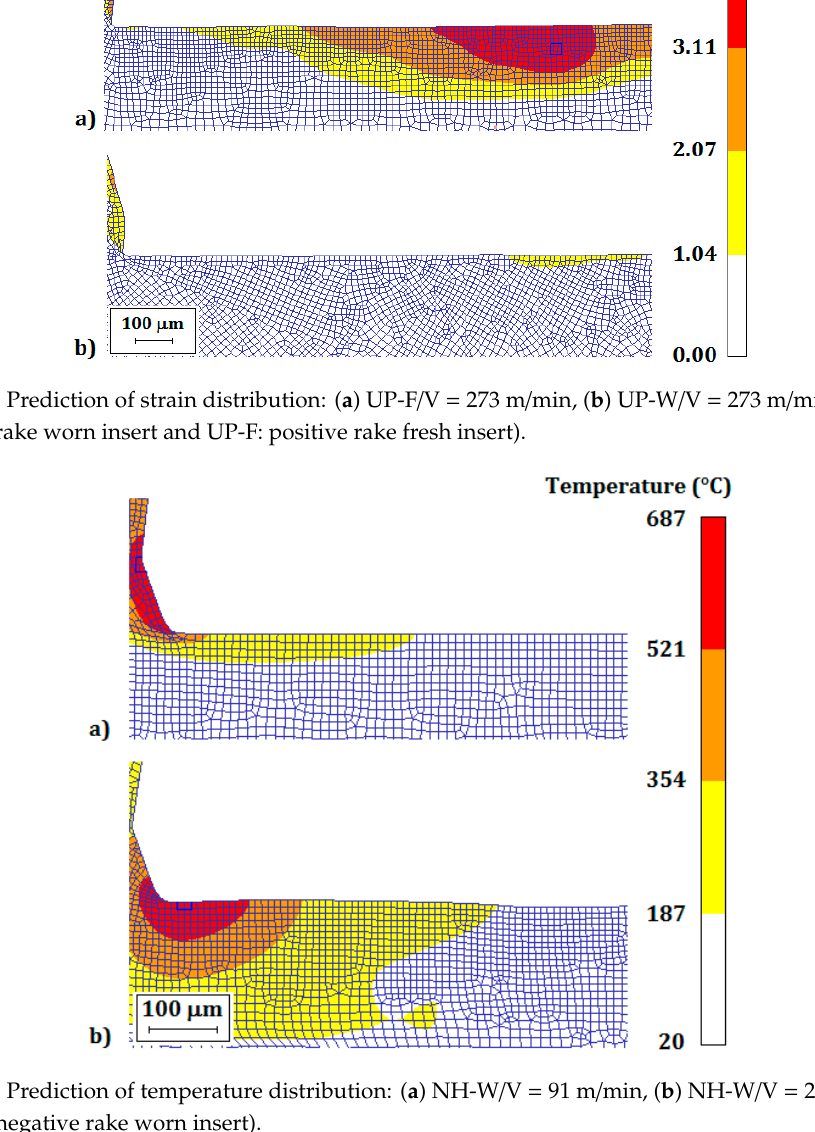
Figure 6. Prediction of temperature distribution: ( a ) NH-W/V = 91 m/min, ( b ) NH-W/V = 273 m/min (NH-W: negative rake worn insert).